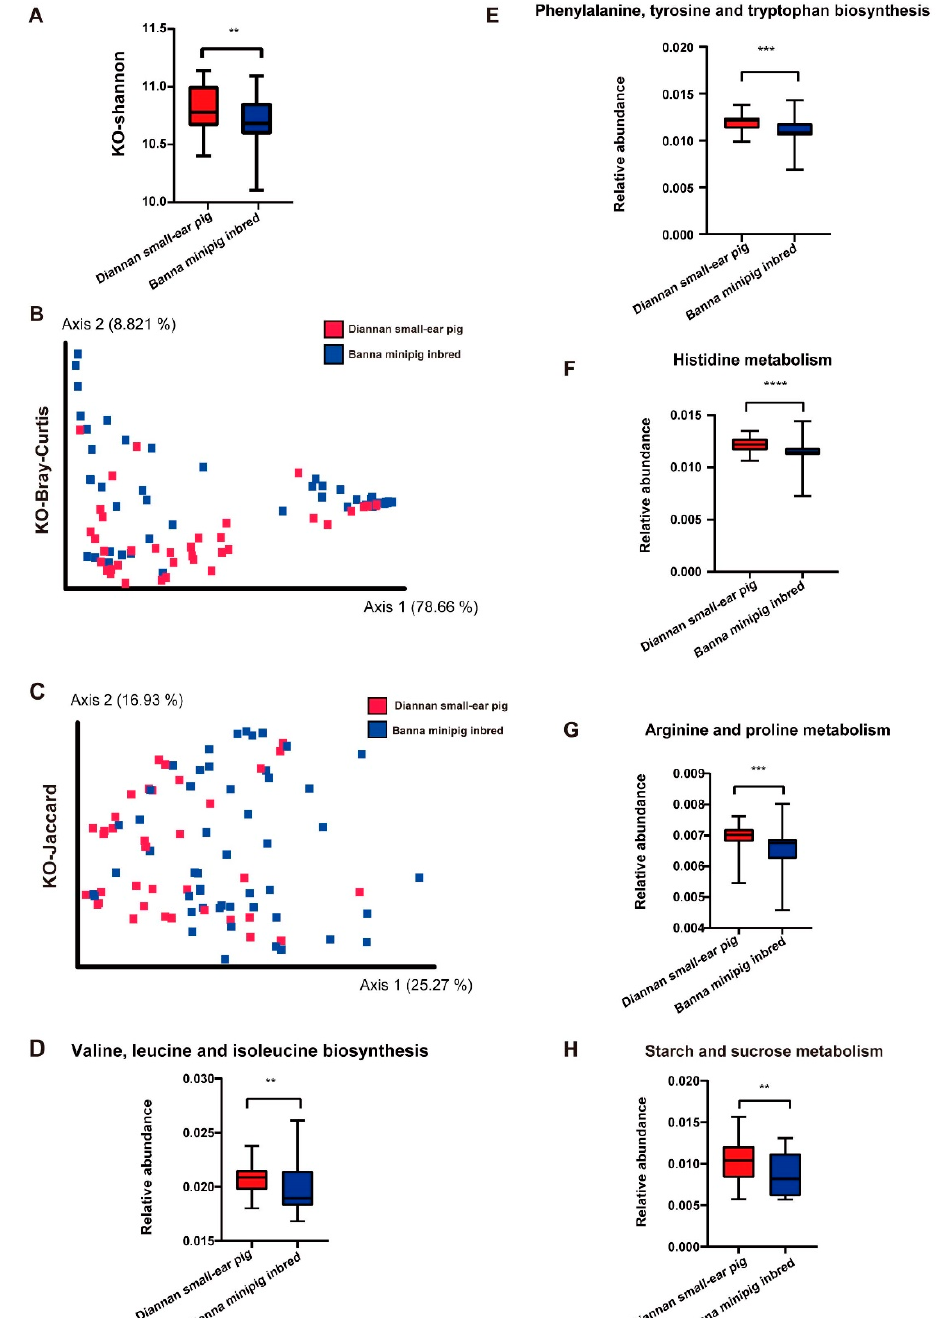
Figure 5. The predicted function of gut microbiota between Diannan small-ear pig and Banna minipig inbred. ( A ): KO–Shannon index between Diannan small-ear pig and Banna minipig inbred. Red and blue bars respectively represent the Diannan small-ear pig and Banna minipig inbred. ( B ): Principle coordinate analysis (PCoA) of KEGG orthologs based on Bray–Curtis distances. ( C ): Principle coordinate analysis (PCoA) of KEGG orthologs based on Jaccard. Red squares and blue circles respectively represent Diannan small-ear pig and Banna minipig inbred. The distance between symbols in the figure reflects the relative difference of community members or structures. The relative abundance of valine, leucine, and isoleucine biosynthesis ( D ), phenylalanine, tyrosine, and tryptophan biosynthesis ( E ), histidine metabolism ( F ), arginine and proline metabolism ( G ), and starch and sucrose metabolism ( H ). Boxplot indicates the interquartile range (IQR). The line in the box represents the middle value, and the error bars respectively represented the lowest and highest values. Mann–Whitney U-test, ** p < 0.01, *** p < 0.001, **** p < 0.0001.